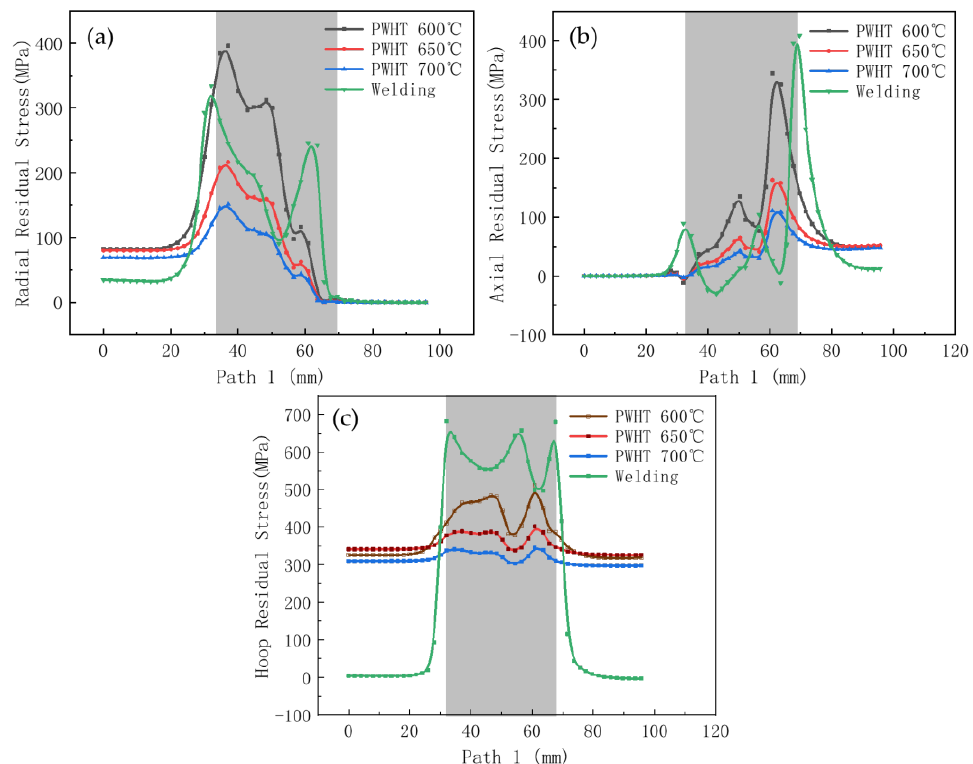
Figure 12. Effect of PWHT temperature on the residual stress distribution of path 1: ( a ) radial, ( b ) axial, ( c ) hoop residual stress.